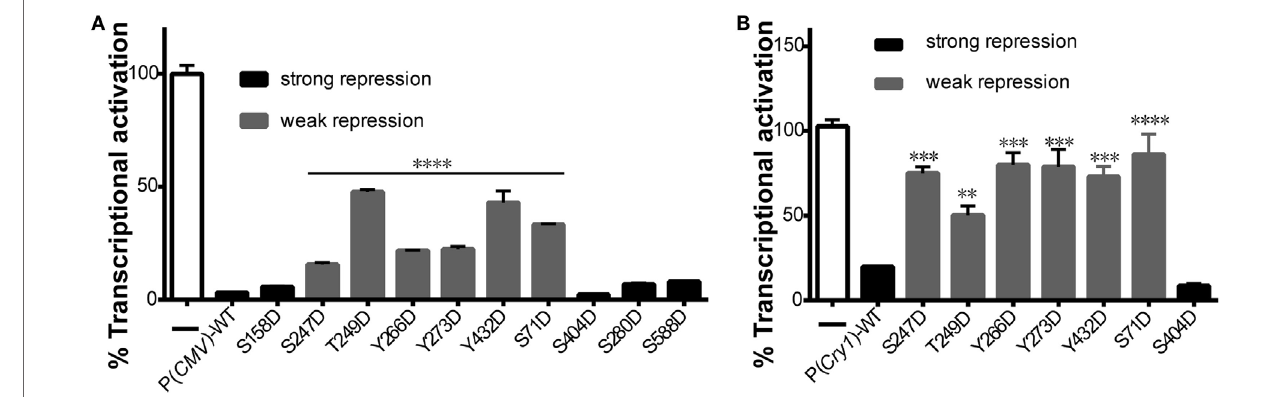
FigUre 2 | effects of mutant mcrY1 on BMal1: clOcK-induced transcriptional activation . (a) HEK293 cells were cotransfected with BMAL1 (10 ng plasmid), CLOCK (15 ng) expression plasmid, and Per2-dluc (10 ng) reporter with WT or mutant mCRY1 (5 ng) as noted. Twenty-four hours after transfection, the cells were changed to luciferin-containing medium for end-point bioluminescence recording. The raw data were normalized such that the reporter control without mCRY1 (WT or mutant) transfection was equal to 100%. Compared with WT mCRY1, the mutants exhibited two profiles: strong repression with similar repression activity to WT and weak repression with a significant reduction in repression activity. Mean and error bars (SEM) of three independent transfections are shown (**** p < 0.0001, ANOVA). Two additional experiments gave similar results. (B) DKO cells were cotransfected with Per2-dluc (10 ng) reporter and WT or mutant mCRY1 (50 ng) as noted. Experiments and data analysis were done as in (a) . Compared with WT, the mutants exhibited two profiles: strong repression with similar repression activity as WT and weak repression with a significant difference. Mean and error bars (SEM) of three independent transfections are shown (** p < 0.01, *** p < 0.001, **** p < 0.0001, ANOVA). Two additional experiments gave similar results.